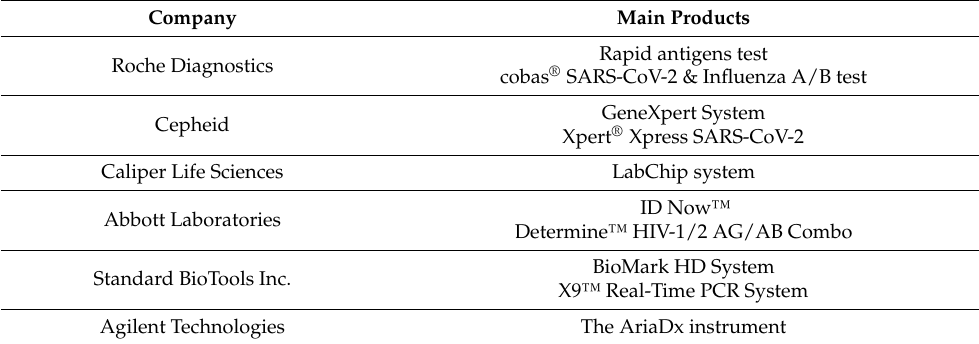
Table 1. Commercialized microfluidic products.